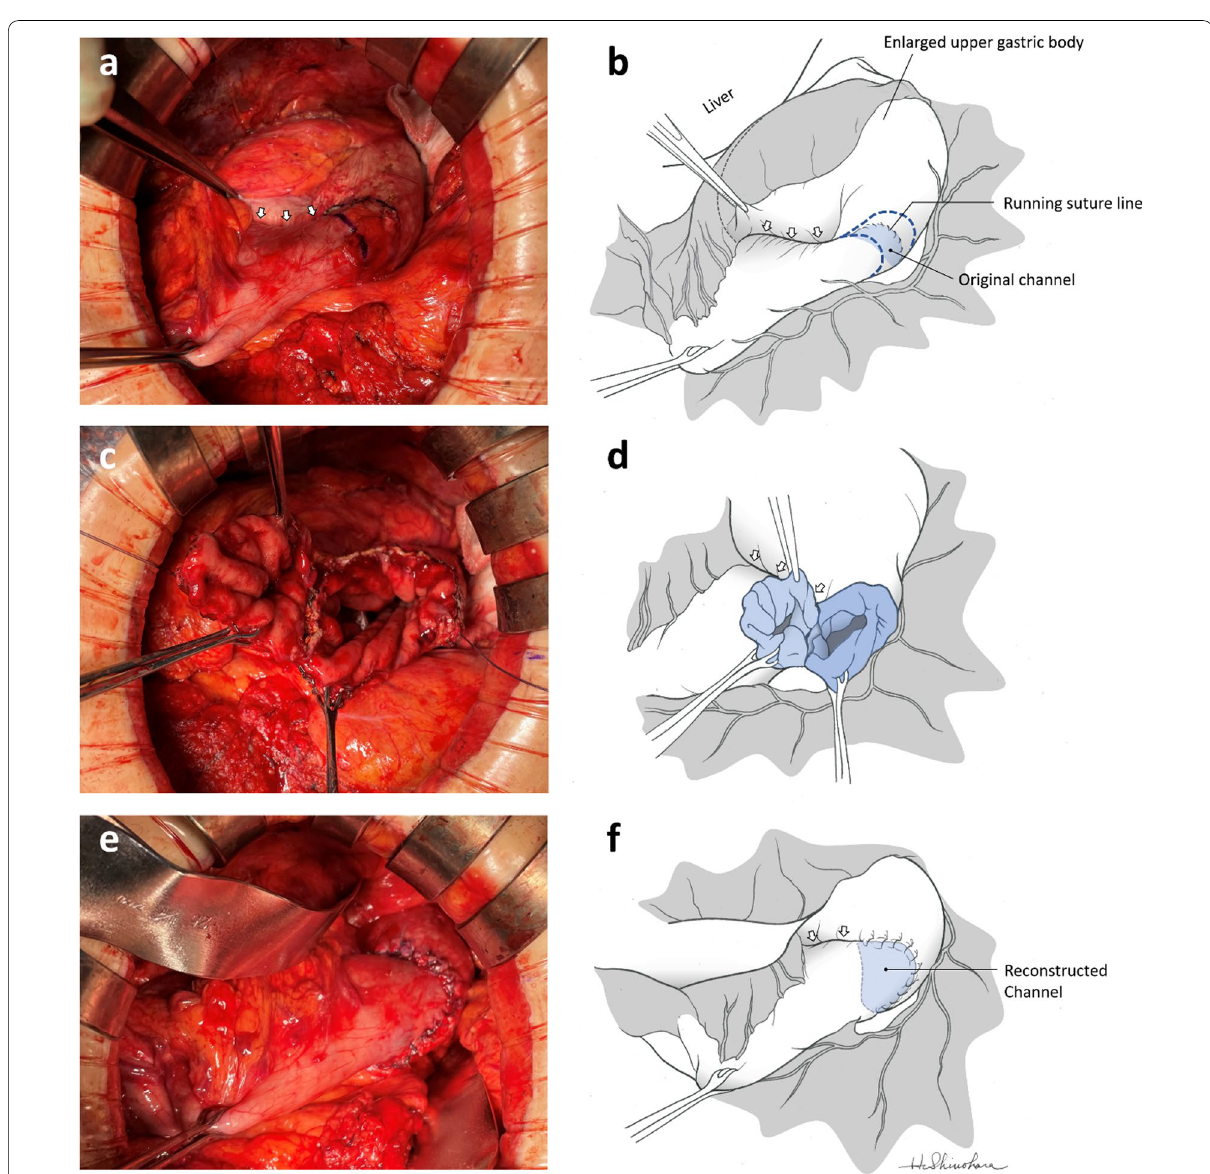
Fig. 2 Surgical findings ( a , c , e ) and corresponding schemas ( b , d , f ). a , b Staple line, indicated by white arrows, was extending from the lesser towards the greater curvature of the upper gastric body. The channel was located on the greater curvature and reinforced with a running seromuscular suture. The resection line was designed as indicated by the broken blue lines in ( b ). c , d Original channel was resected and the diameter of the new channel increased to 30 mm. e , f New channel was constructed by double-layer anastomosis with interrupted